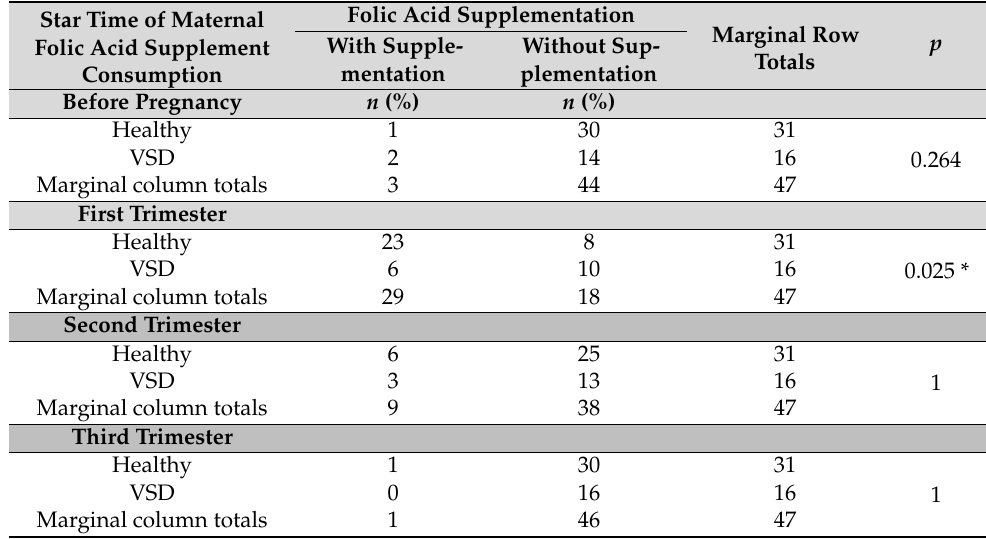
Table 3. Associations between the start time of maternal folic acid supplement consumption and the presence of VSD.